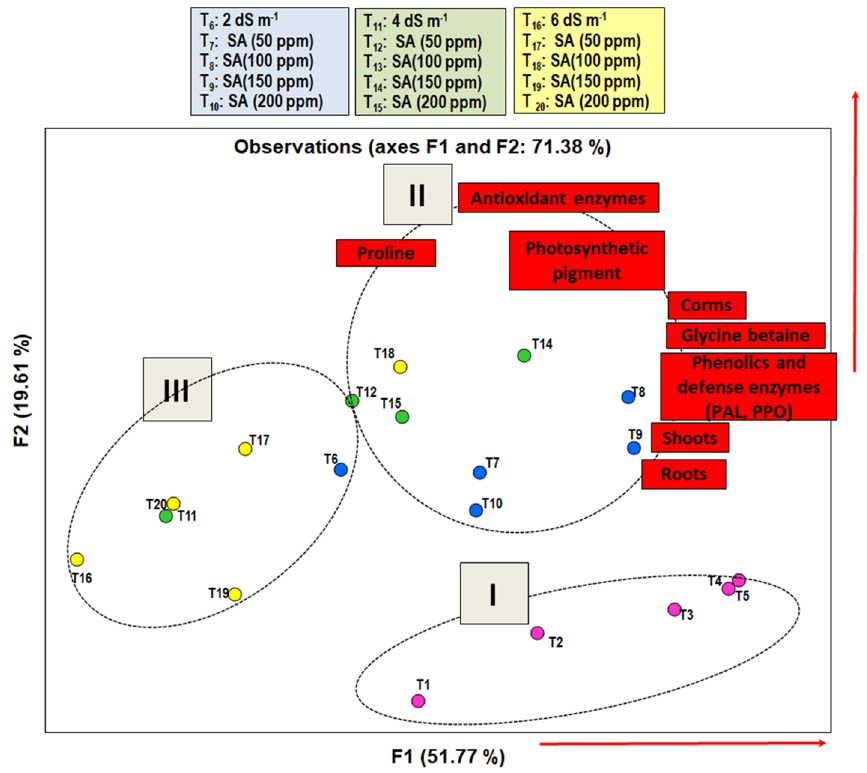
Figure 8. Principal component analysis (PCA) describing effect of salinity and salicylic acid in all 20 treatments in Gladiolus grandiflorus and their relationship with the morpho-physiological